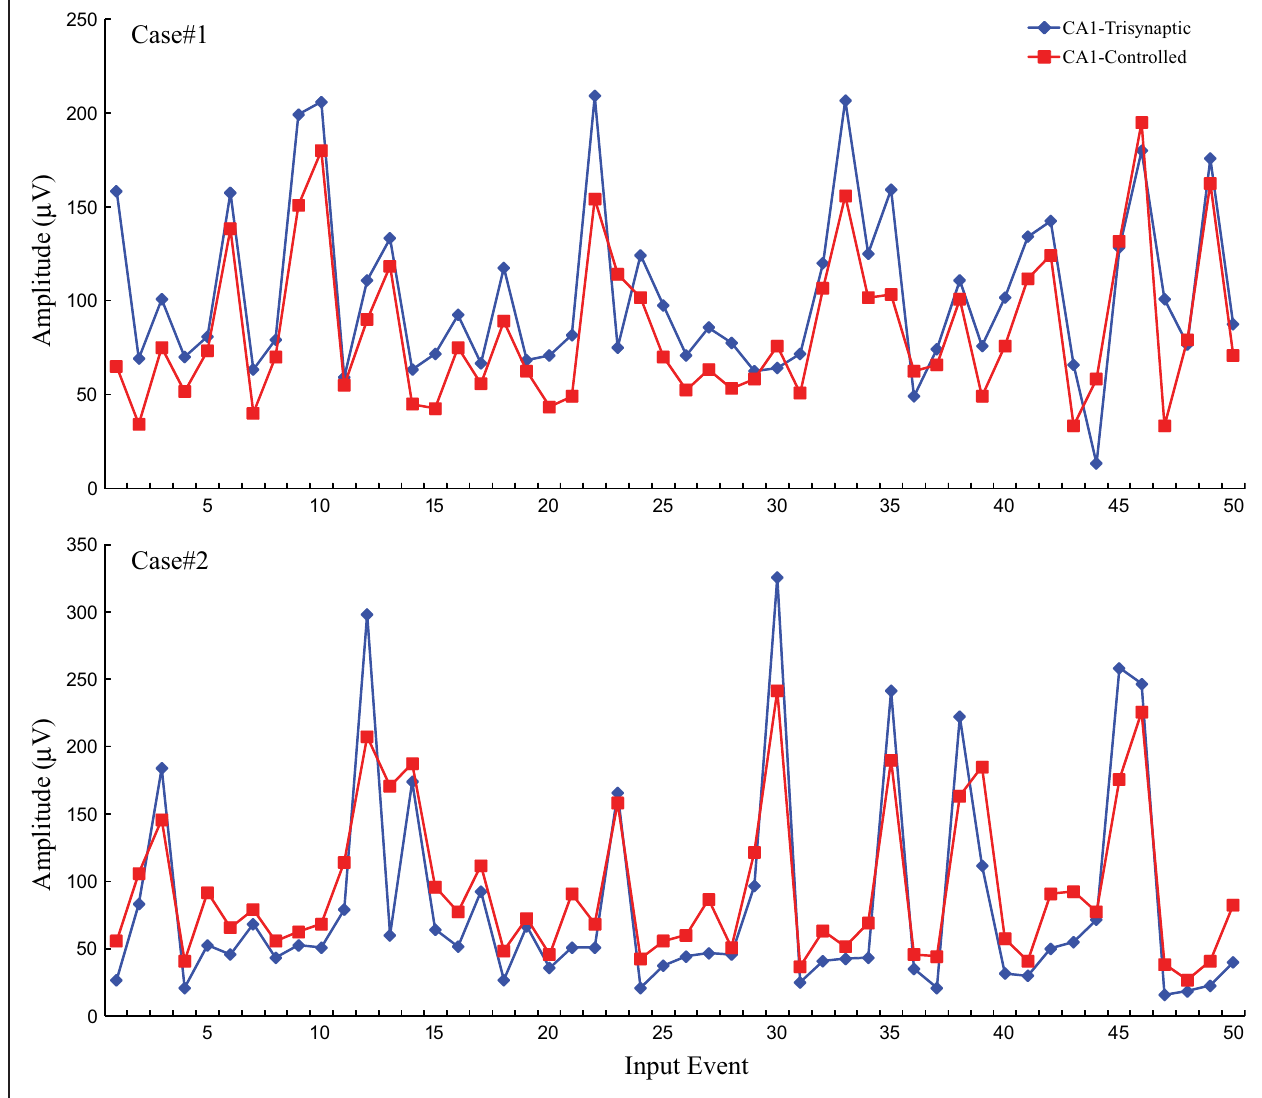
FIGURE 7 | A comparison of CA1 fEPSP amplitudes in response to FARIT-induced trisynaptic response (CA1-trysynaptic in blue diamonds) and DARIT-induced monosynaptic response (CA1-Controlled in red squares). The NMSE from 6 datasets was 15 . 41 ± 8 .